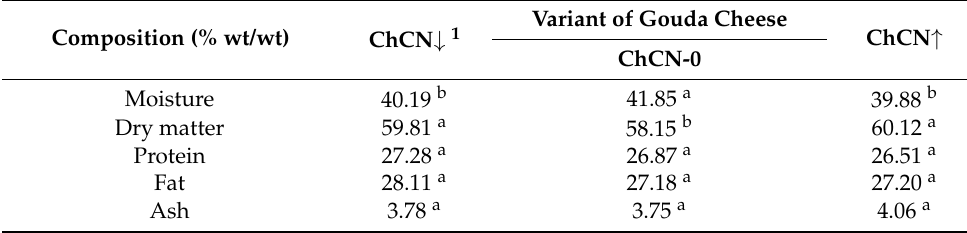
Table 4. The composition of different variants of Gouda cheese (data concerns cheeses after 60 days of